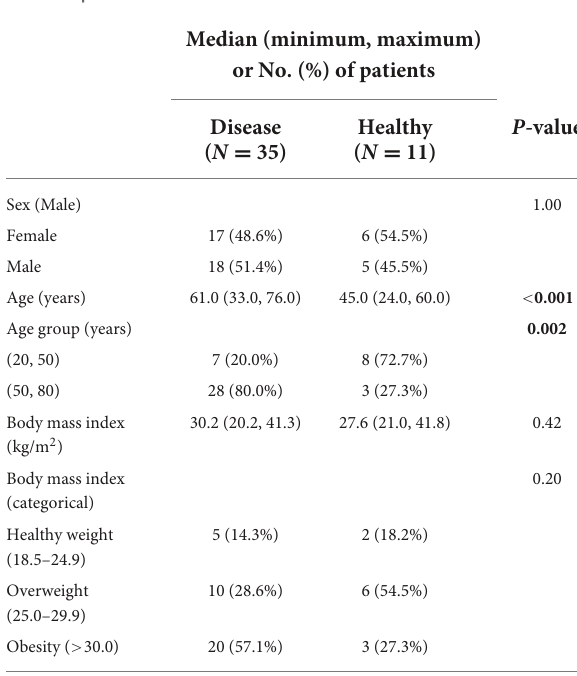
TABLE 1 Comparison of demographics between healthy and cirrhosis